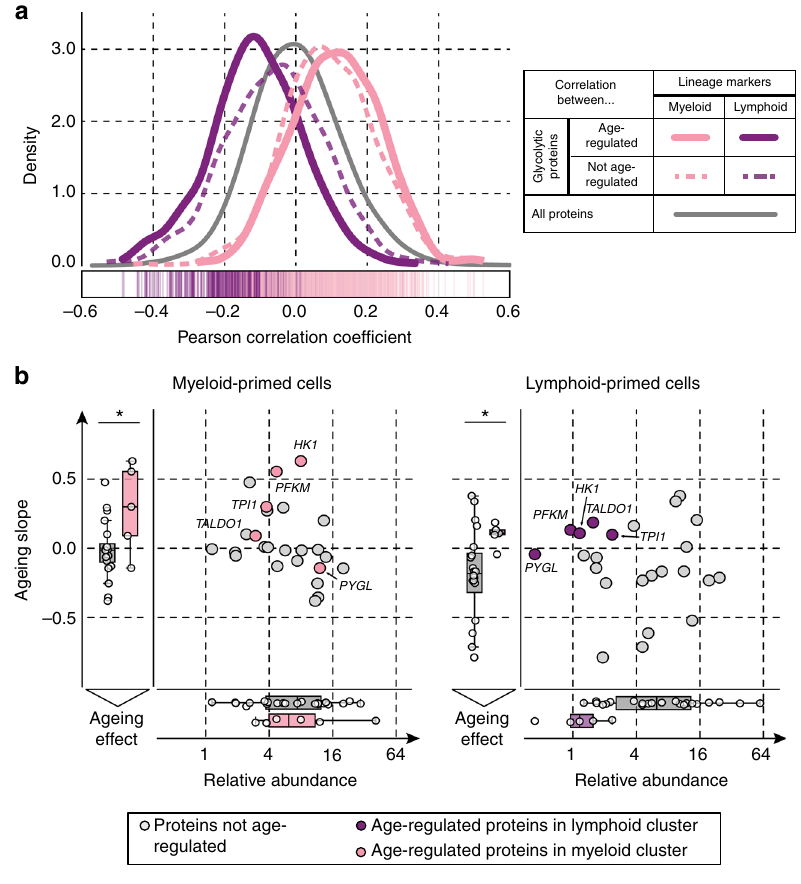
Fig. 7 Single-cell analysis reveals lineage- and age-dependent increase of glycolytic enzymes. a The density plot shows distributions of correlation coef fi cients (Pearson) between lineage markers and glycolytic enzymes. The calculation is based on the results from the single-cell RNA-seq data. Density distributions based on correlations between myeloid (pink) or lymphoid (purple) markers with glycolytic enzymes that were up-regulated upon ageing, are shown with thick lines. The corresponding individual correlation values are displayed as lines in the box below the plot in the respective colours. Density distributions based on correlations of the respective markers with glycolytic and TCA-related proteins that did not change upon ageing are shown as dashed coloured lines. The grey distribution represents the correlation values of all proteins against myeloid and lymphoid markers. b Scatter plot illustrating the effect of ageing on glycolytic enzymes in lymphoid- and myeloid-primed cells, as deduced from single-cell analysis. The dots correspond to proteins in glycolysis that were not affected by age (grey), and glycolytic proteins that were altered upon ageing according to the proteomics data. The x - axis illustrates the relative abundance of those enzymes in myeloid-primed cells (left), and lymphoid-primed cells (right). The y -axis corresponds to the ageing slope derived as a measure of age-effect in lymphoid- and myeloid-primed cells across donors *p value < 0.05, Mann – Whitney U -test (see also Supplementary Fig. 12a, b). The data from the scatter plots are collapsed into box plots on both axes with the central mark indicating the median, the bottom and top edges of the box indicating the IQR. The box plot whiskers represent 1.5 times